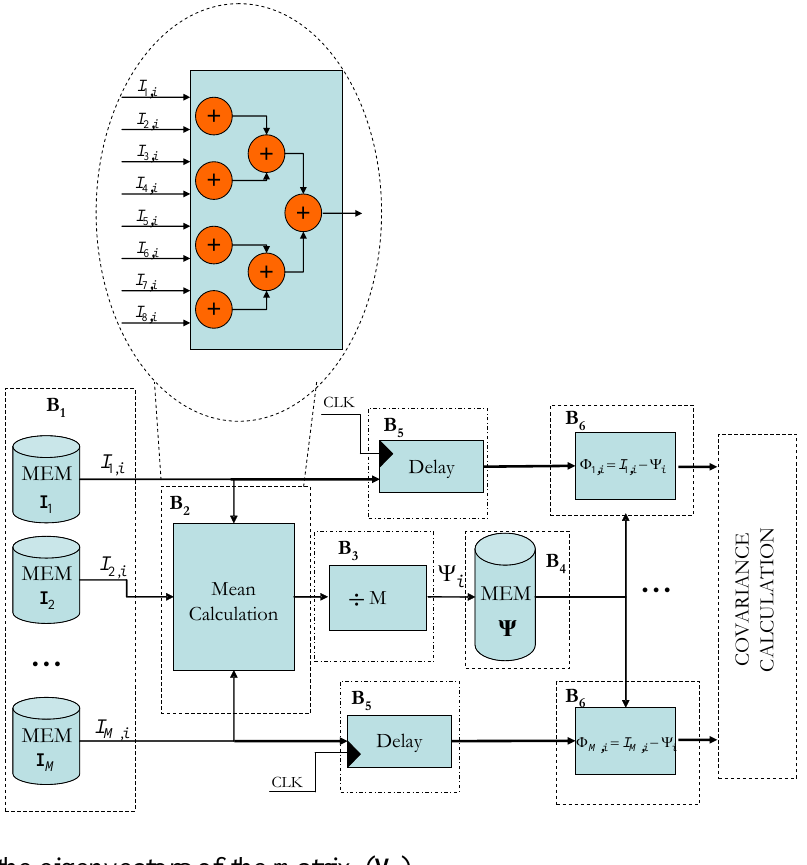
Figure 3. Block diagram of the proposed circuit for calculating the mean   Ψ of the M captured